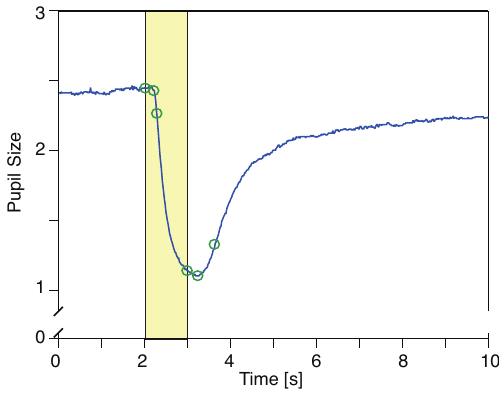
Figure 2. Feature extraction from PLR responses at two levels of brightness (10 and 100 cd/m 2 ). These stimuli were labelled as r10, r100, b10, b100, w10 and w100.